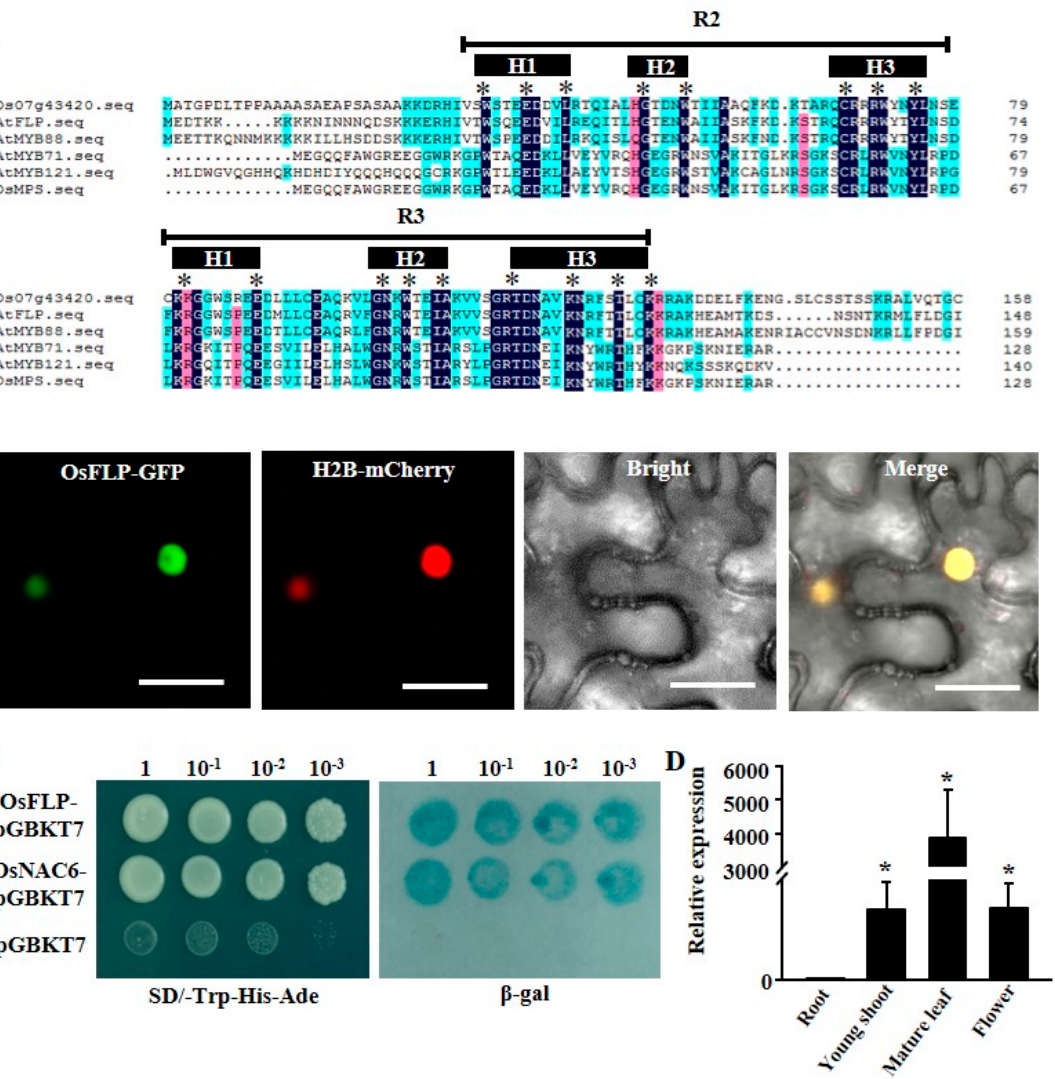
Figure 1. Category, subcellular localization, transcriptional activation and tissue expression of OsFLP. ( A ) Alignment of amino acid sequences of the OsFLP (Os07g43420) DNA-binding domain and homologous R2R3 − -MYB proteins in A. thaliana (AtFLP/At1g14350, AtMYB88/At2g02820, AtMYB71/At3g24310, AtMYB121/At3g30210) and O. sativa (OsMPS/Os02g40530). ( B ) The subcellular localization of OsFLP in leaf epidermis cells of tobacco. OsFLP was fused with GFP. H2B-mcherry was the nucleus localization marker. OsFLP is mainly localized at the nucleus. Bars = 20 µm. ( C ) Analysis of transcription activation of OsFLP. The fusion protein of the GAL4 DNA-binding domain and OsFLP were expressed in yeast strain AH109. The vector pGBKT7 was expressed as a negative control and OsNAC6 as a positive control. The transformed yeasts were grown on SD plates without tryptophan, histidine and adenine. The plates were incubated for 3 days and then subjected to a β -galactosidase assay. ( D ) Quantitative real − time PCR (qRT − PCR) was performed to analyze the ex- pression of OsFLP in different tissues, including roots, young shoots, mature leaves and flowers. High expression was detected in young shoots, mature leaves and flowers. Data represent means ± SD ( n = 3 replicates). The statistically significant differences are indicated with asterisks: * p <